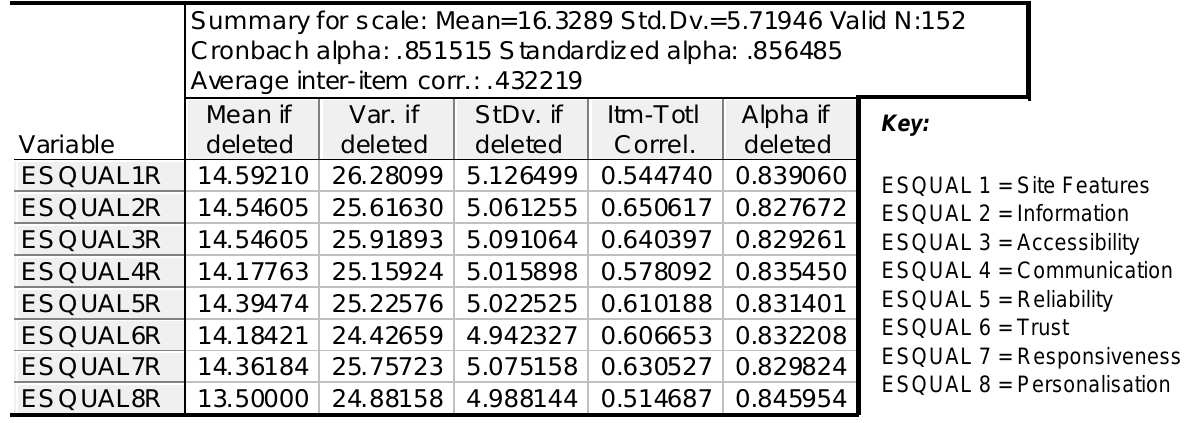
Table 1: Item-reliability analysis for the E-Service Quality